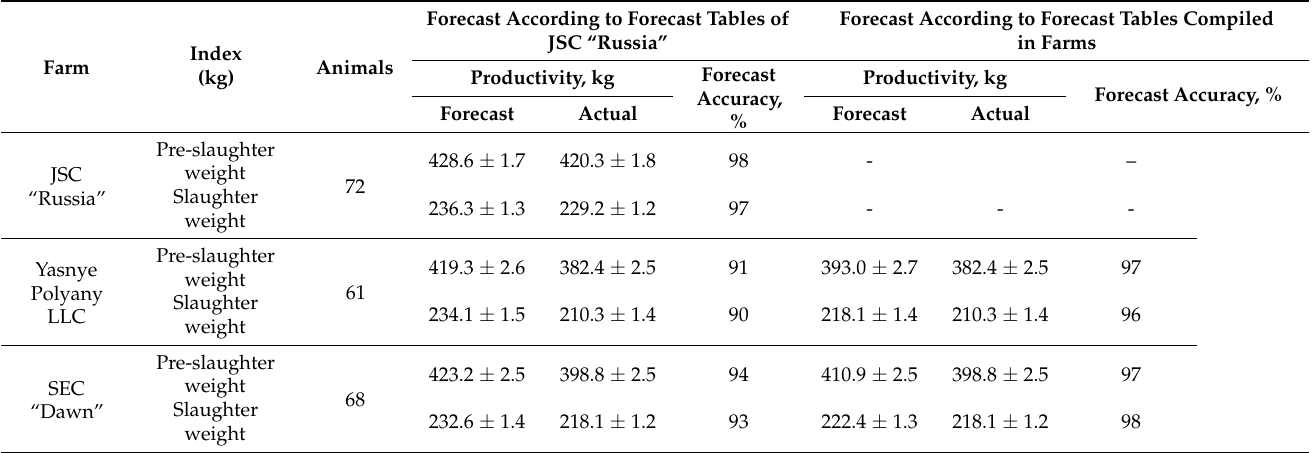
Table 7. Results of approbation of the method of forecasting the meat productivity of animals in the farms of the Chelyabinsk